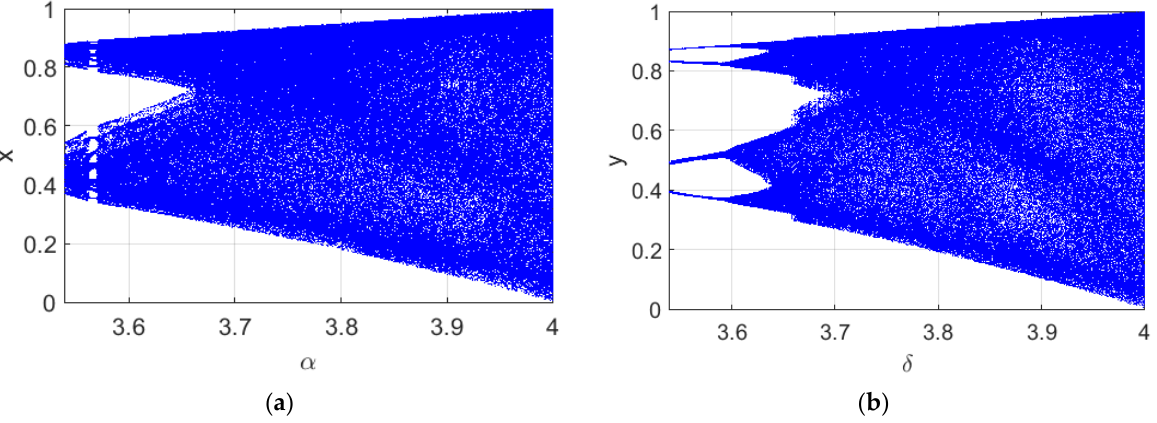
Figure 1. The bifurcation diagram of x ( a ) and y ( b ) sequences produced by 2DSCLM